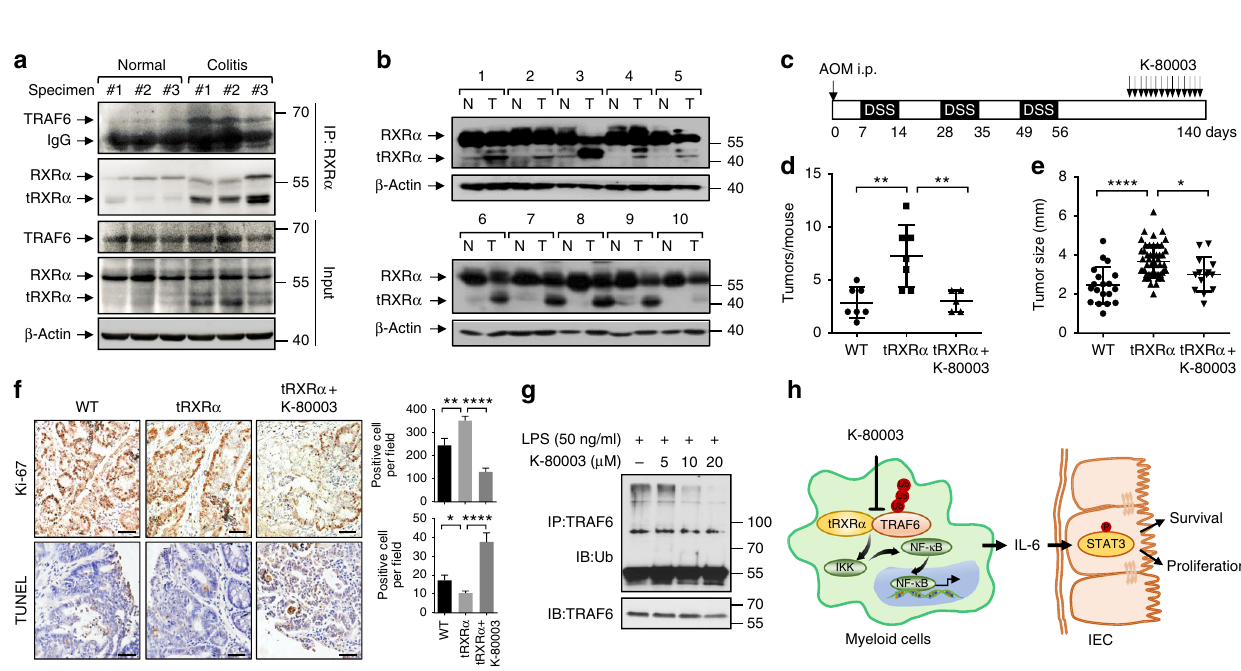
Fig. 7 Expression of truncated retinoid X receptor α (tRXR α ) in human specimens and the inhibitory effect of K-80003 on tRXR α -mediated colorectal carcinogenesis. a tRXR α expression and interaction with TRAF6 in ulcerative colitis patients. Lysates of colorectal tissues from healthy and ulcerative colitis patients were analyzed by immunoblotting and co-immunoprecipitation assay using Δ N197 anti-RXR α antibody. b The expression of RXR α /tRXR α were immunoblotting in tumor tissue (T) and corresponding adjacent normal tissue (N) from 10 colorectal tumor patients. c Schematic representation of the azoxymethane (AOM)/dextran sodium sulfate (DSS) protocol and K-80003 treatment. Mice were treated with AOM/DSS for 125 days and then administered with vehicle control or K-80003 (20 mg/kg) via oral gavage for 2 weeks daily. d Average tumor number. Data points represent the tumor number of one individual mouse. The horizontal bar represents the mean ± SD ( n = 7/5), one-way analysis of variance (ANOVA). e Average tumor size. Each dot represents a tumor. The horizontal bar represents the mean ± SD, one-way ANOVA. f Representative images of colon cancer stained with Ki-67 antibody or with the terminal deoxinucleotidyl transferase-mediated dUTP- fl uorescein nick end labeling (TUNEL) Kit. Ki67-positive or TUNEL-positive cells per fi eld were counted. Data are mean ± SEM, one-way ANOVA. Scale bar, 100 μ m. g THP-1 cells pretreated with the indicated concentrations of K-80003 before exposed to lipopolysaccharide (50 ng/ml) were subjected to immunoprecipitation assay using anti-TRAF6 antibody and analyzed for TRAF6 ubiquitination by immunoblotting. h Schematic of tRXR α activation of the nuclear factor- κ B pathway in macrophages and its role in promoting colon cancer cell survival and proliferation through induction of signal transducer and activator of transcription factor 3 activation. * P < 0.05, ** P < 0.01, *** P < 0.001. For immunoblotting, one of three or four similar experiments is increased when they were cultured with CM from tRXR α - BMDMs but not from control BMDMs (Fig. 5i). CM from tRXR α -BMDMs could also potentiate the effect of LPS on activating STAT3. Similar results were obtained when THP-1 cells were analyzed. In this case, transfection of tRXR α but not of RXR α strongly induced the expression of IL-6 and TNF α (Supplementary Fig. 5a). CM from tRXR α -transfected but not in human HCT-116 colon cancer cells (Supplementary Fig. 5b).